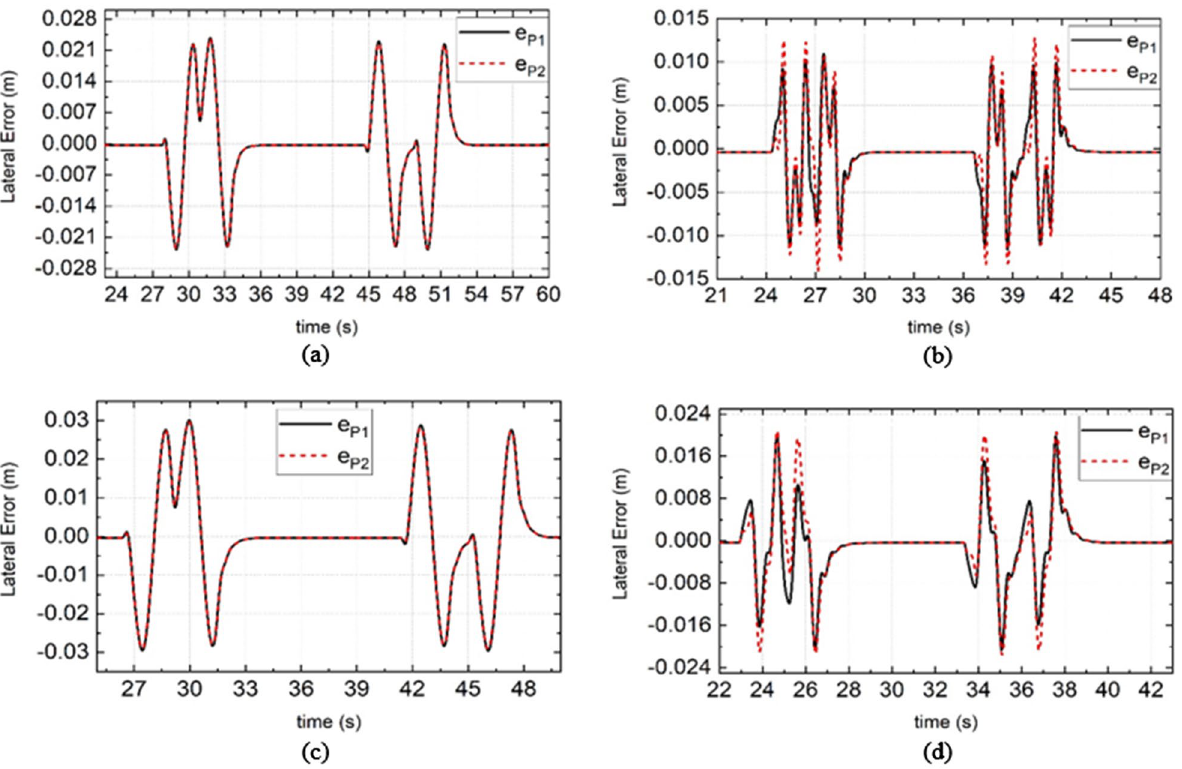
Figure 7. Simulation results of lateral tracking errors under different road adhesion coefficient and different vehicle speed. ( a ) Is the simulation results of DDAV running at 40 km/h on wet road, ( b ) is the simulation results of DDAV running at 55 km/h on wet road, ( c ) is the simulation results of DDAV running at 45 km/h on dry road, ( d ) is the simulation results of DDAV running at 65 km/h on dry road.